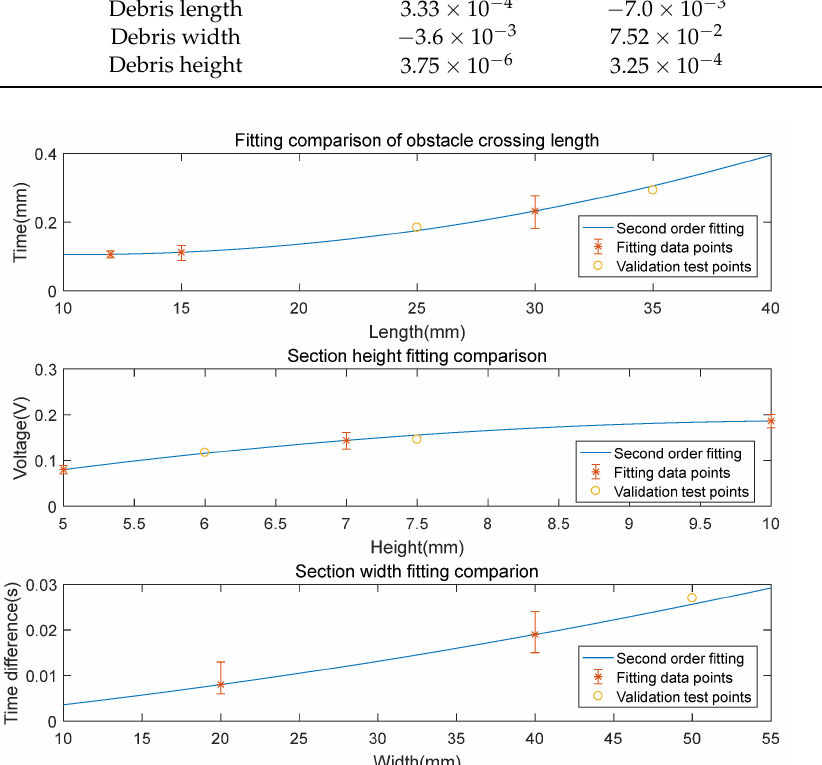
Figure 12. Debris dimension regression results and